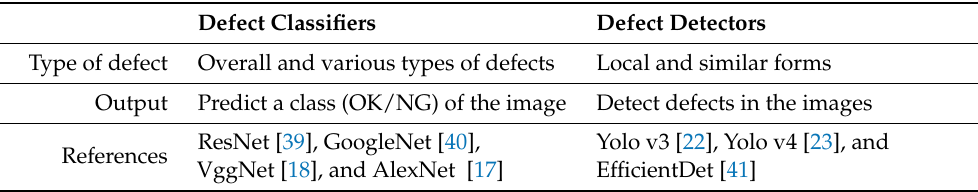
Table 2. Differences between classification and